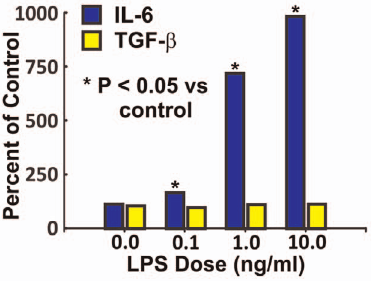
Figure 12. AT 1 R inhibitor losartan does not attenuate LPS- induced cardiac fibrosis. Percent collagen fraction area in the left ventricle by picrosirius red staining (mean + SEM, n=5) increased with LPS (P , 0.001, 2 way ANOVA). LPS effects were not affected when the AT 1 R inhibitor losartan was added to the drinking water (P=0.80). Losartan alone had no effect. There was no significant interaction between LPS and losartan (P=0.70).